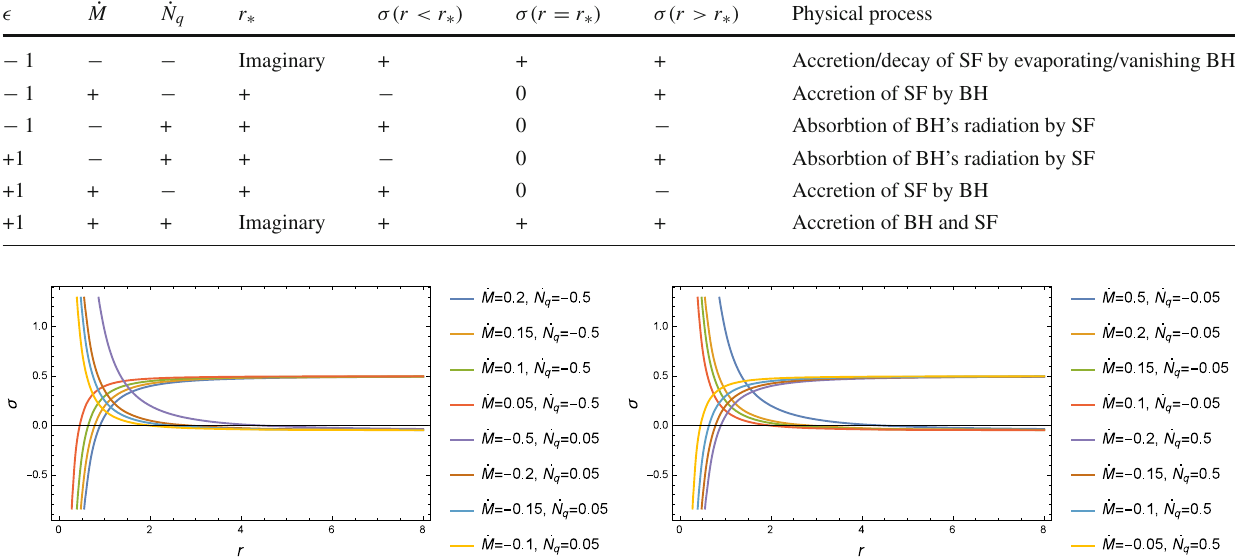
Fig. 10 Left figure: the radiation-accretion density σ versus the dis- tance r for some typical constant ˙ M and ˙ N q values for (cid:5) = − 1 in the quintessence background. In the four upper cases, the accretion density is an increasing function from negative to the positive values. In the four lower cases, the radiation density is a decreasing function decreases from positive values to negative values. Then, for a dynam- ical quintessence background, if the condition | ˙ N q ( u ) | (cid:11) | ˙ M ( u ) | is not met, the positive energy condition is violated in some regions of